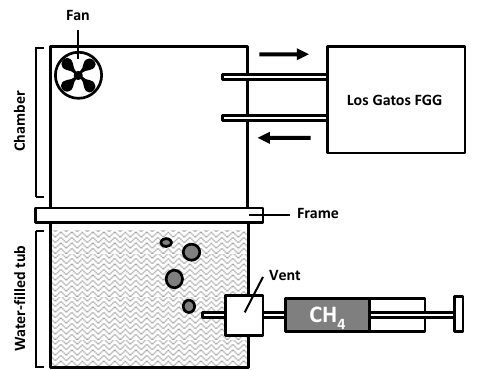
Figure 5. Scatter plot of the amount of injected CH 4 and the cor- responding calculated CH 4 ebullition event. The solid black line indicates the 1:1 agreement. The linear fit between the displayed values is represented by the black dashed line, surrounded by the 95% confidence interval (grey shaded